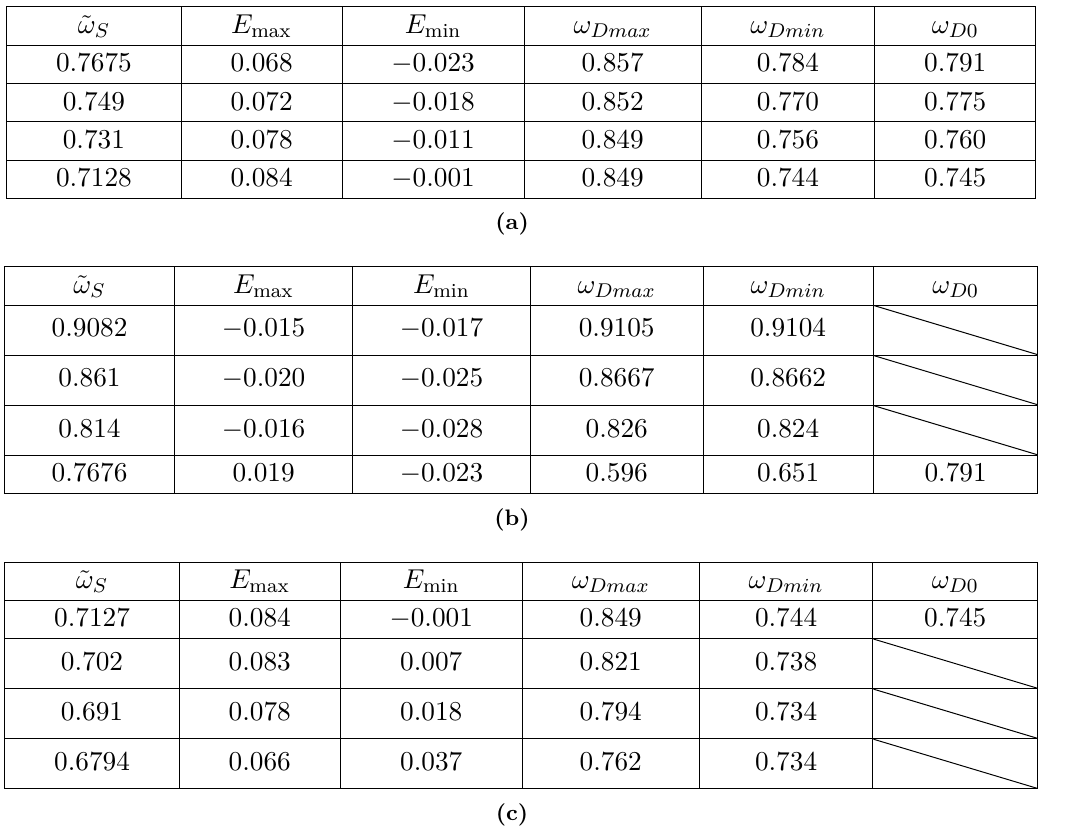
Table 5. For multi-branch (top panel), one-branch-A (middle panel) and one-branch-B (bottom panel) solution families, the maximum value E max and the minimum value E min of the binding energy E B of the DBSs, the nonsynchronized frequency ˜ ω D corresponding to E max and E min ( ω Dmax and ω Dmin ). ω D 0 is the value of the nonsynchronized frequency ˜ ω D when E B = 0 .